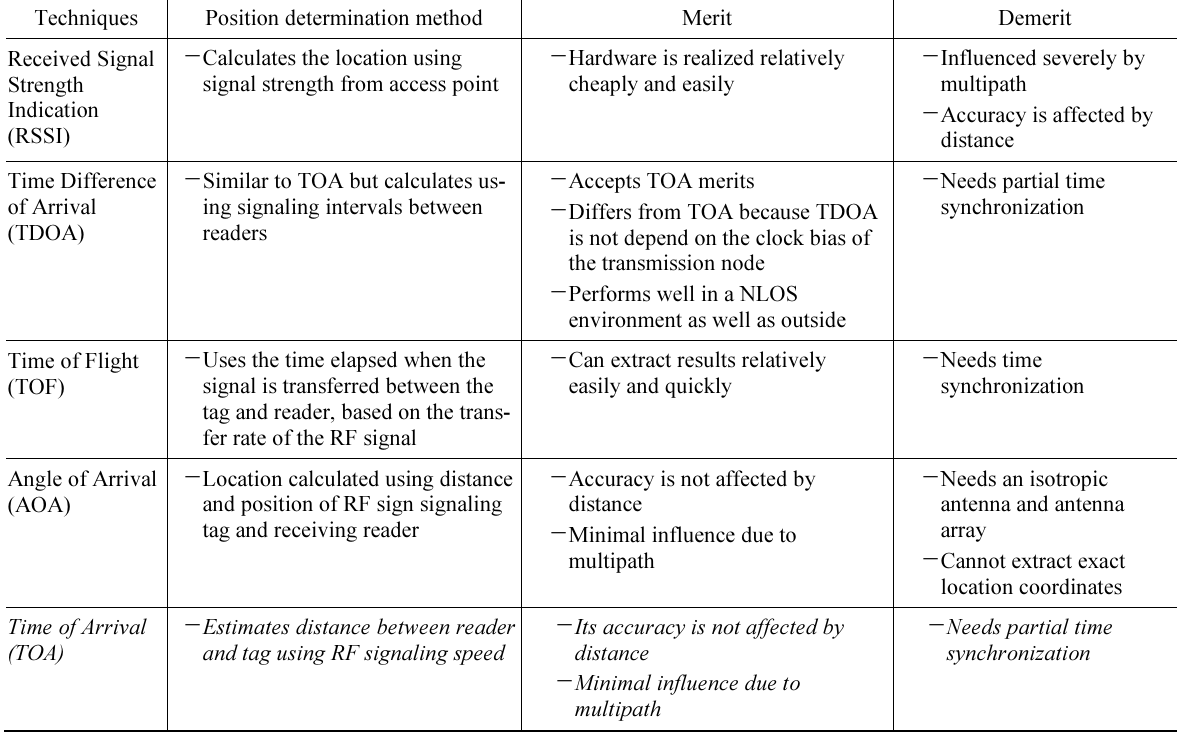
Table 3. Position determination method (based on Bahl and Padmanahan 2000)